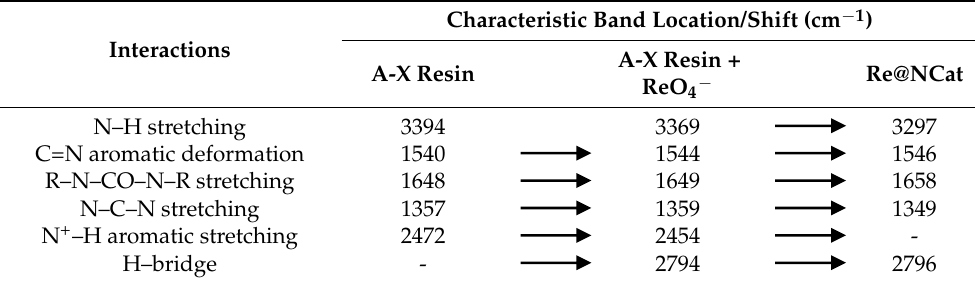
Table 1. The location of FT-IR bands found in the anion exchange resin (polymeric base) before and after sorption of ReO 4- ions, as well as in the resulting Re@NCat.